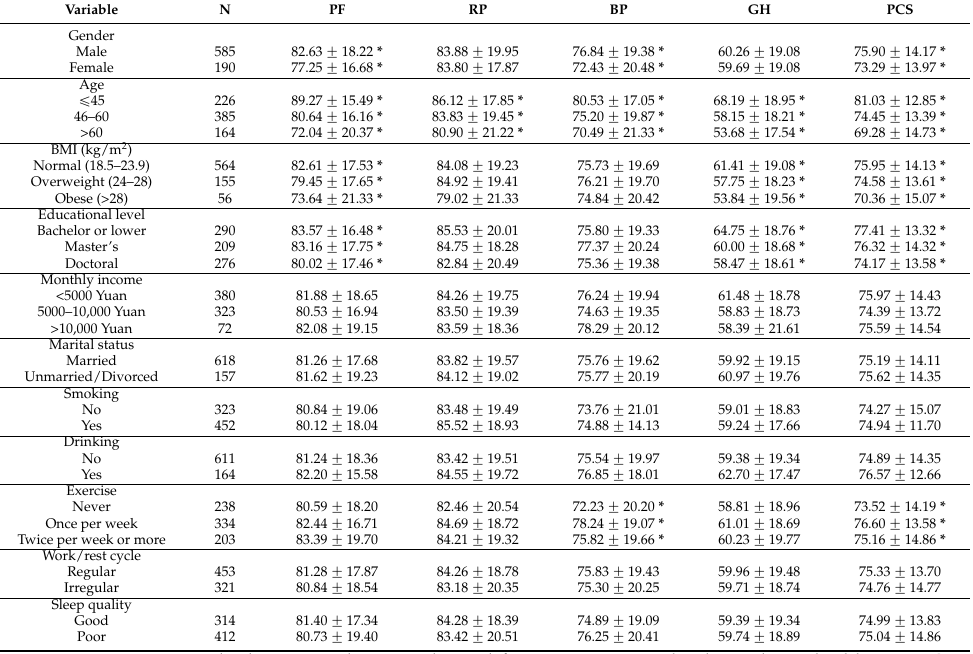
Table 1. PF, RP, BP, GH and PCS scores based on the characteristics of scientific workers (Mean ˘